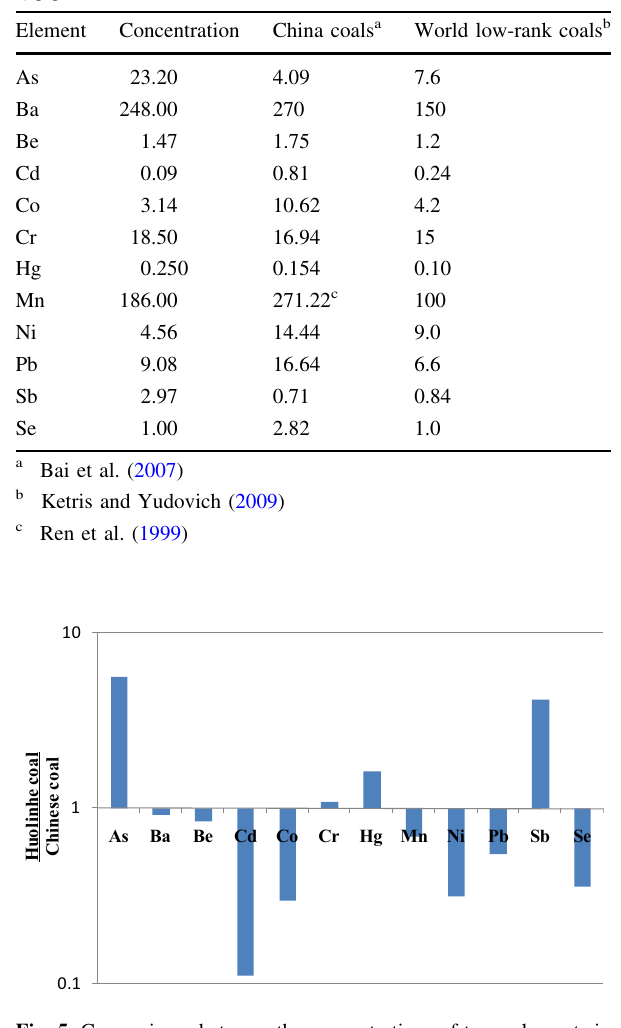
Table 3 Element concentrations in No.14 coal from Huolinhe mine ( l g/g)